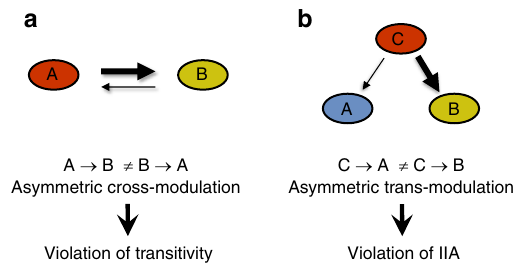
Fig. 8 Asymmetric modulatory effects between options underlie irrational decision making. a Asymmetric cross-modulatory effects between two options (out of a set of three options), where option A affects preference towards option B differently than option B affects preference towards option A (A → B ≠ B → A) can explain violation of the transitivity principle. b Asymmetric trans-modulatory effects, where option C differently affects preferences towards options A and B (C → A ≠ C → B), may explain